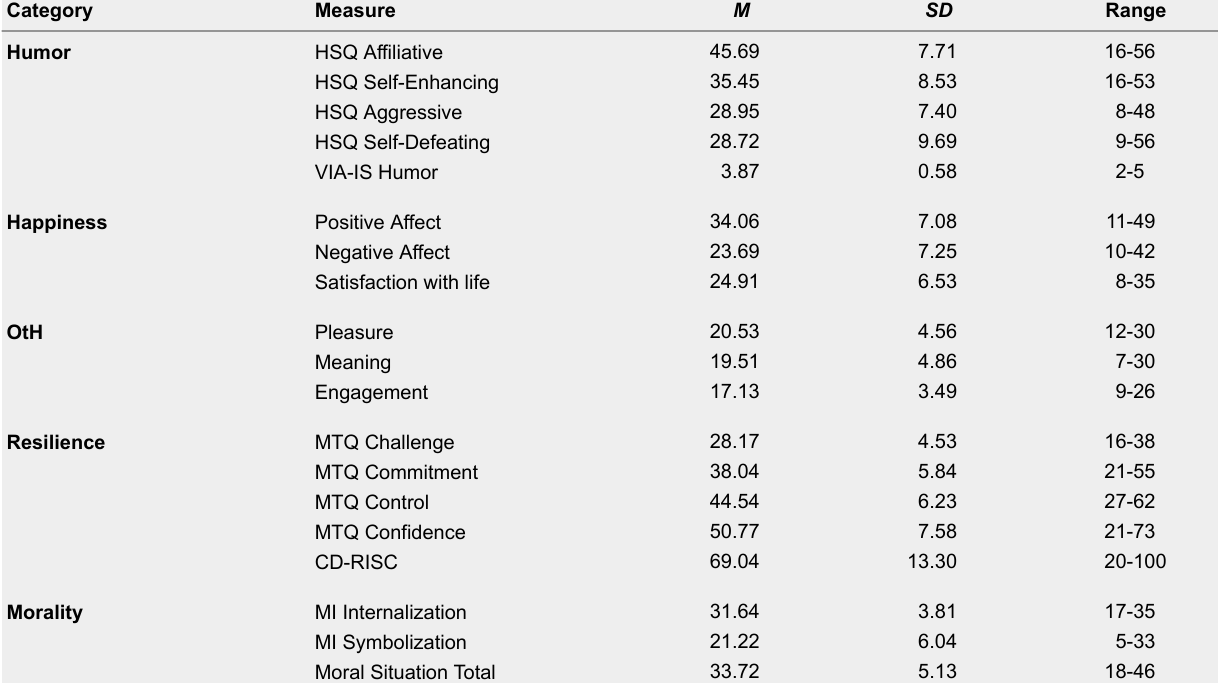
Means, Standard Deviations, and Ranges for All